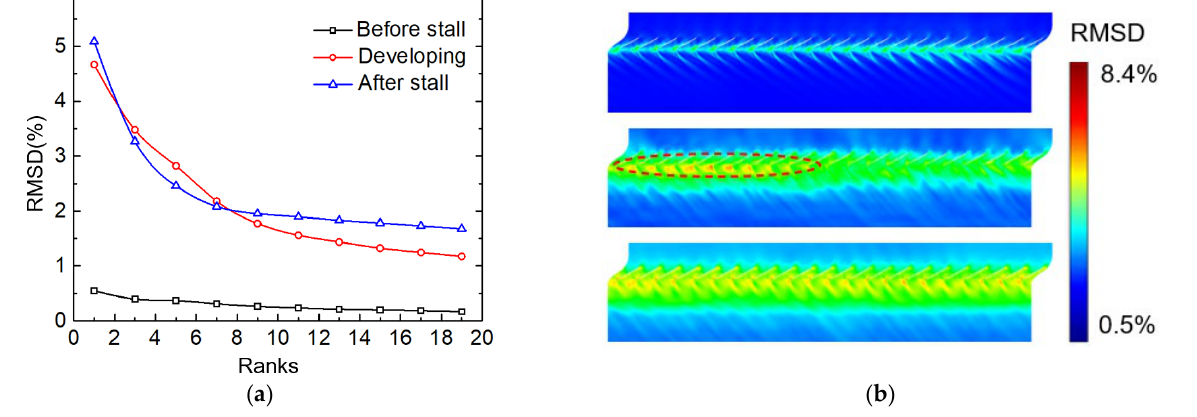
Figure 10. Comparison of reconstruction errors at different stages. ( a ) Variation of RMSD with re- configuration rank. ( b ) Spatial distribution of RMSD. reconfiguration rank. ( b ) Spatial distribution of RMSD.